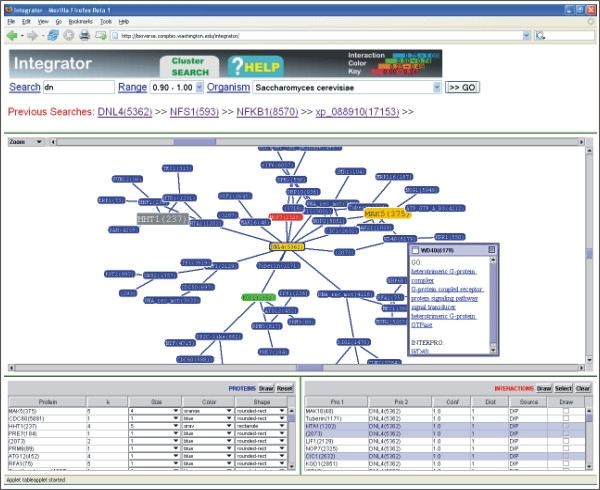
The Integrator network viewer interface. Shown here is a representative network search result around a selected node (yellow) with various other nodes modified for color, size, or shape. The center frame contains the main interactive graph viewer. Users can traverse a network by clicking on nodes. Double-clicking on a node opens a window containing detailed sequence and annotation information. Hovering over nodes also brings up tool tips containing GO and Interpro annotations. Hovering over edges shows tool tips with edge confidence data. Right-click contextual menus also exist for nodes and edges which allow for search, hiding, showing, and changing their visual properties. The slider bar at the top of the graph viewer modulates zoom, rotation, or viewable neighborhood size. Below this are two interactive network tables, nodes on the left, edges on the right. These tables can be used to sort and modify various node and edge properties in the viewer.